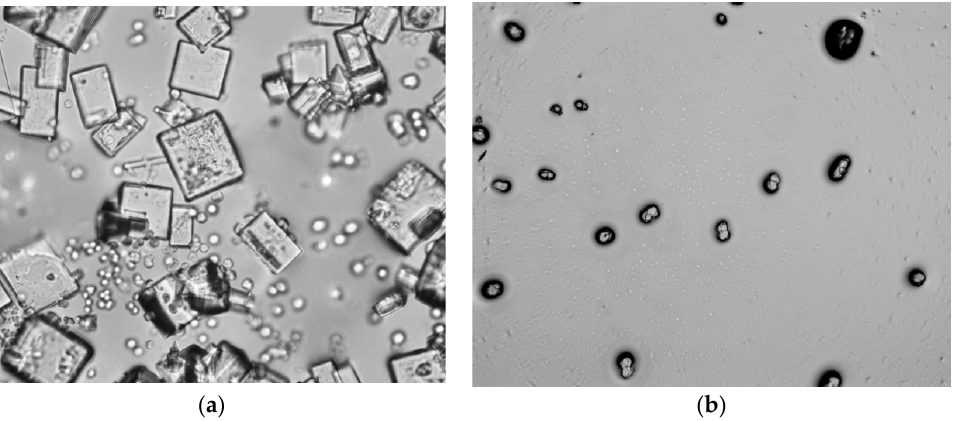
Figure A6. Trial RT2: Transmitted light photomicrographs of evaporated water: ( a ) Seawater (ISE = 38.56 g NaCl L − 1 ; evaporation = 41.21 g L − 1 ); ( b ) product water (ISE = 1.34 g NaCl L − 1 ; evaporation = 0.56 g NaCl L − 1 ). The crystals are NaCl. Field of view = 0.8 mm.